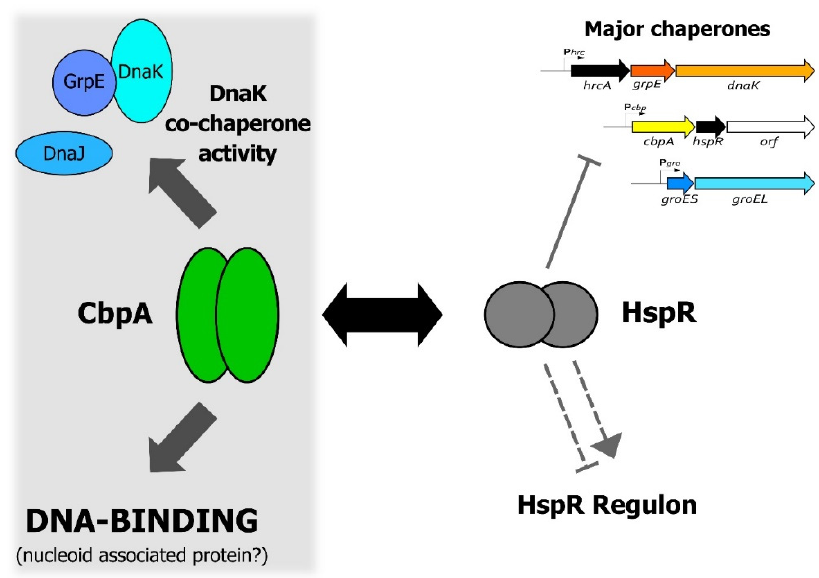
Figure 6. A model representing the functional interplay between CbpA and HspR in H. pylori . The figure shows a schematic representation of both CbpA and HspR functional activities and highlights the CbpA-HspR direct protein–protein interaction (black double arrow). Symbols are as follows: the grey filled hammerhead indicates HspR direct repression of the multicistronic operons containing the major H. pylori chaperone genes; the grey dashed hammerhead and arrowhead depict negative and positive indirect HspR-mediated regulation of target genes, respectively [23]. Confirmed activities of CbpA are depicted on the right-hand part of the figure, while more speculative activities are confined to the left-hand part of the figure on the grey background.